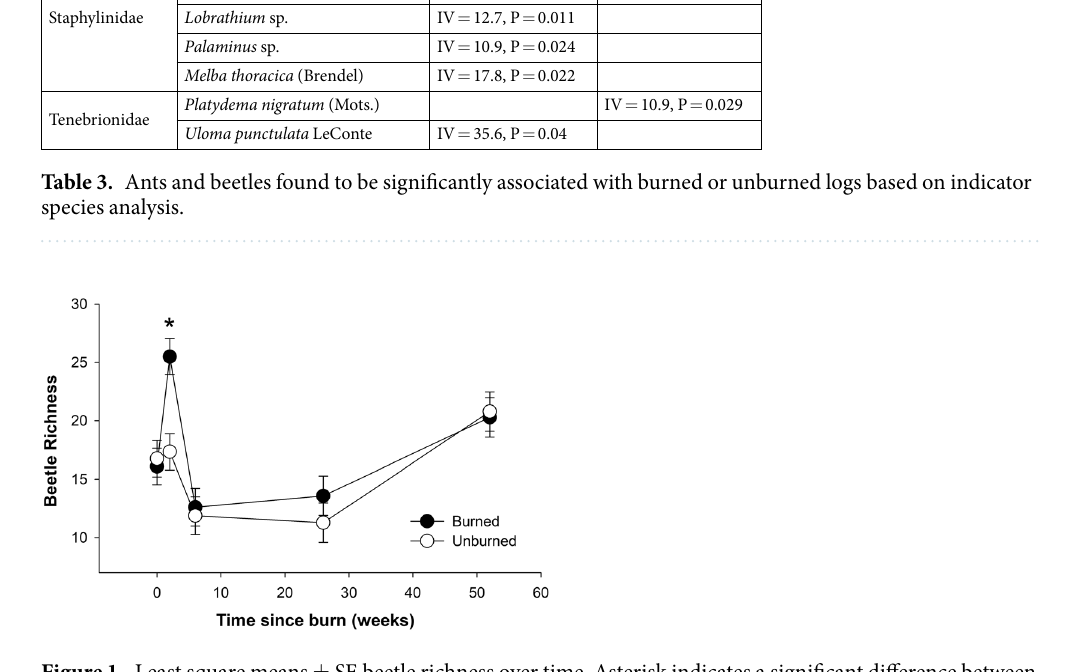
Figure 1. Least square means ± SE beetle richness over time. Asterisk indicates a significant difference between treatments at 2 weeks but not at any other time period.